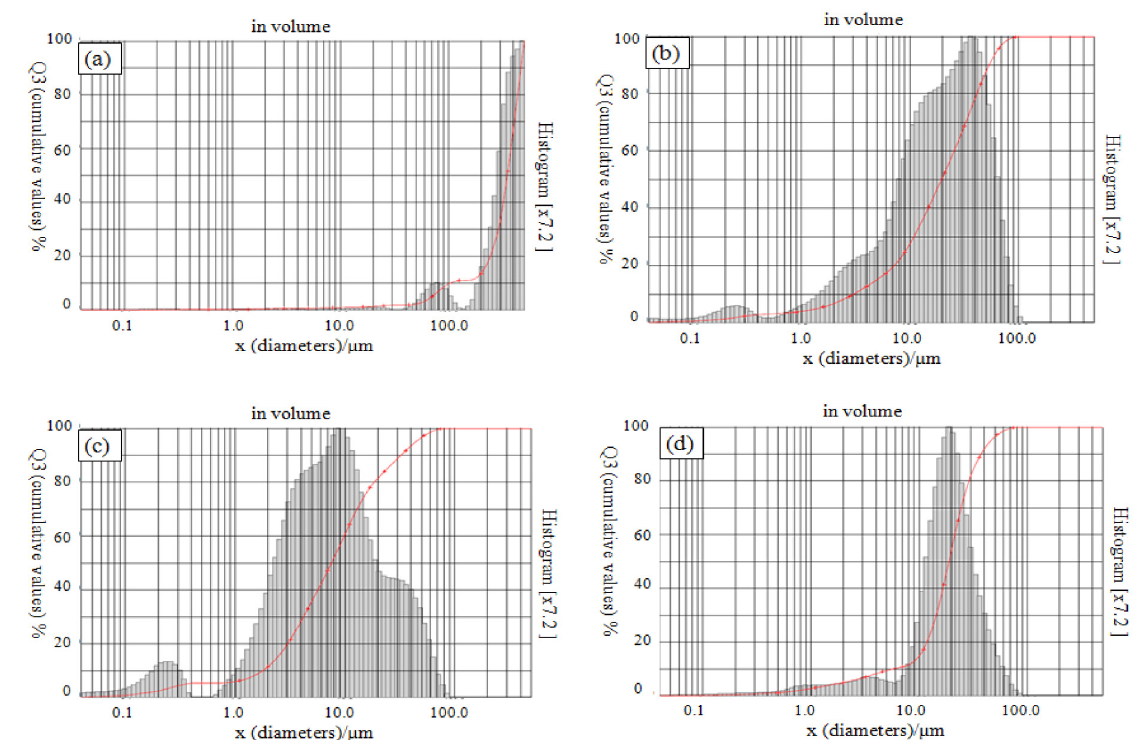
FIGURE 3 - Particle size distribution by laser diffraction of gelatin (a), M0 (b), MG (c) and MR (d).